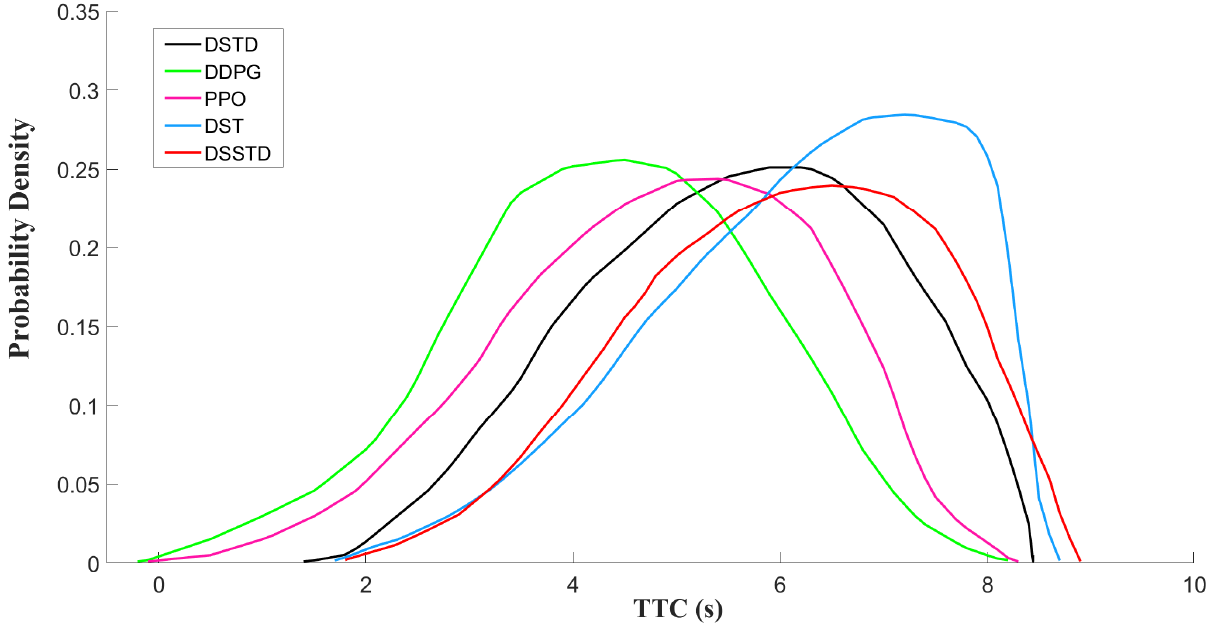
Figure 12. Distribution of the TTC of the proposed RL algorithm and the traditional RL algorithm. (2) Driving efficiency: The test rounds with an initial speed of 10 m/s were used and the